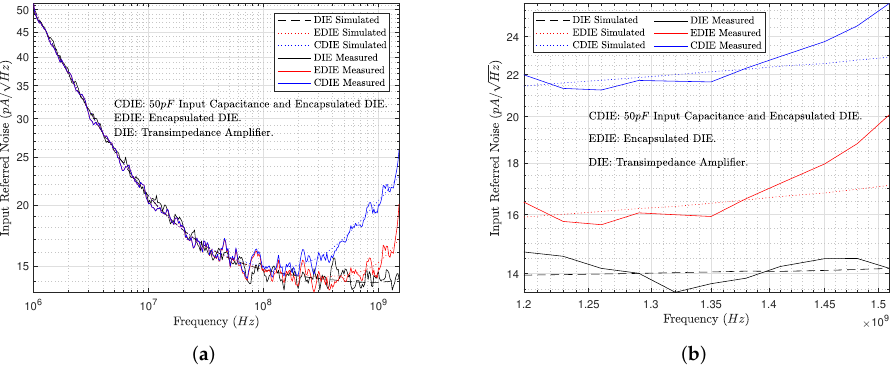
Figure 5. Simulated and measured input-referred noise of the TIA. ( a ) From 1 MHz to 1.2 GHz. ( b ) From 1.2 GHz to 1.5